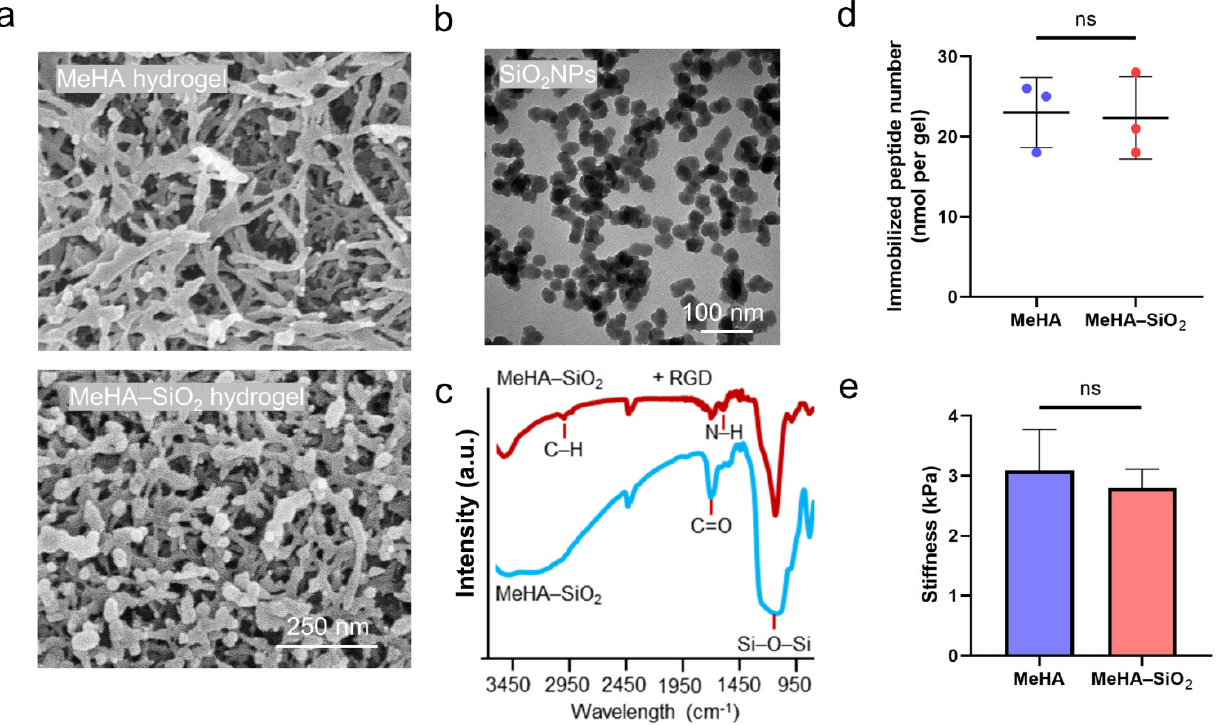
Figure 2. Material characterization of the soft nanocomposite hydrogel. ( a ) scanning electron microscopic (SEM) images of MeHA (up) and MeHA–SiO 2 (down) hydrogels. ( b ) Transmission electron microscopic (TEM) images of the prepared SiO 2 NPs. ( c ) Fourier-transformed infrared spectra of MeHA–SiO 2 hydrogel (blue line) and MeHA–SiO 2 hydrogel with RGD conjugation (red line). ( d ) quantification of immobilized RGD number in both hydrogels. ( e ) Stiffness measurement of the hydrogels. The error bars represent the s.e.m. ns represents statistically not significant by one-way ANOVA.